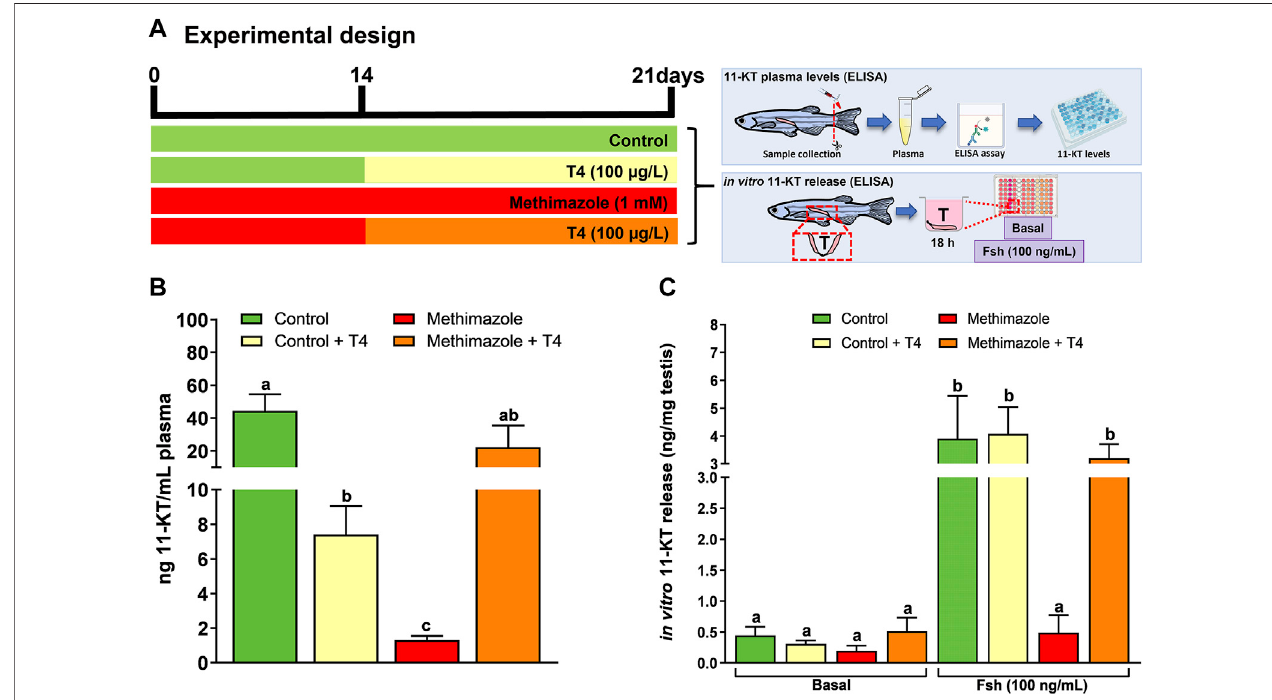
FIGURE4|(A) Experimentaldesign.11-Ketotestosterone(11-KT)plasmalevels(ng/mLplasma)wasevaluatedinzebra fi shmalesexposedtodifferenttreatments: Control(non-treated fi sh),T4(100 μ g/L),methimazole(1 mM)andmethimazole(1 mM)+T4(100 μ g/L).Amountsof11-KT(ng/mgoftestisweight)releasedbyzebra fi sh testes were measured in the incubation media after 18 h (short-term exposure) in the presence or absence of Fsh (100 ng/ml) from control, T4, methimazole and methimazole + T4 groups. (B) Effect of T4, methimazole and combination of methimazole and T4 on 11-KT plasma levels. (C) Androgen (11-KT) release from zebra fi sh testicular explants previously treated with T4, methimazole or methimazole co-treated with T4. Bars represent the mean ± SEM ( n = 8). ANOVA followed by Tukey ’ s test. Different letters denote signi fi cant difference ( p < 0.05) between different treatments compared to the respective control